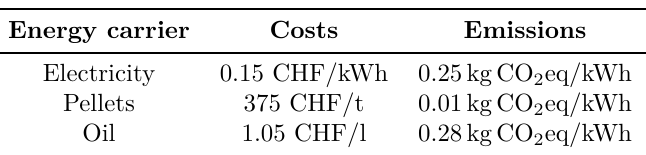
Table 1. Energy costs and emission factors of different energy carriers.